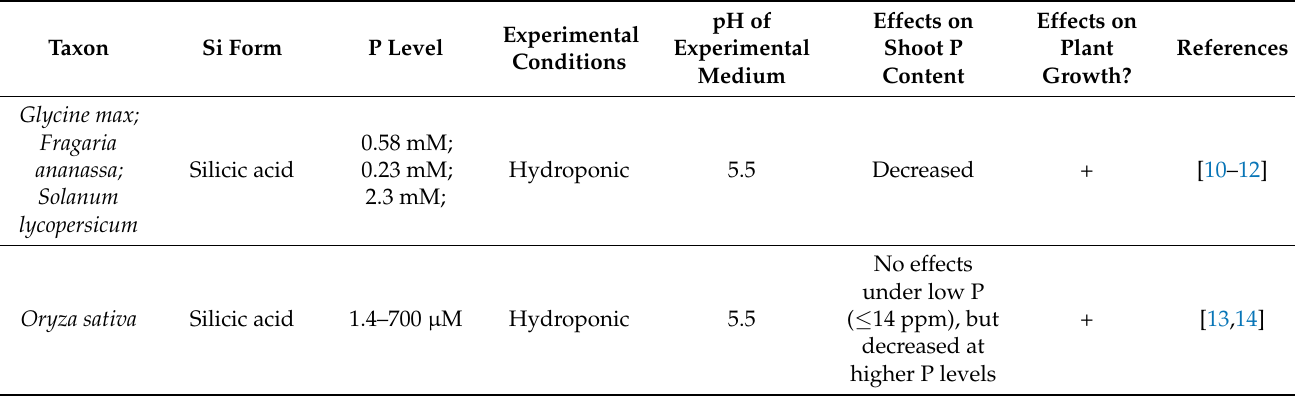
Table 2. Summary of effects of silicon (Si) on phosphorus (P) content and plant growth: ( − ) inhibition, (+) stimulation, and (0) no